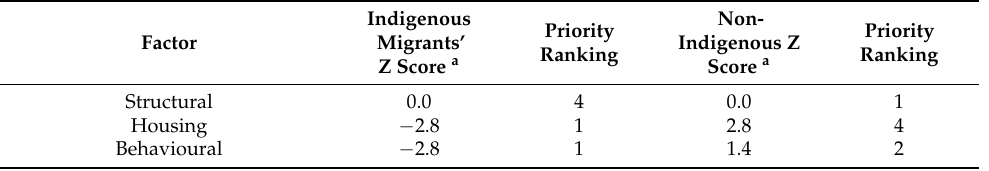
Table 4. Priority ranking for addressing social determinants and health needs according to indigenous migrant and non-indigenous